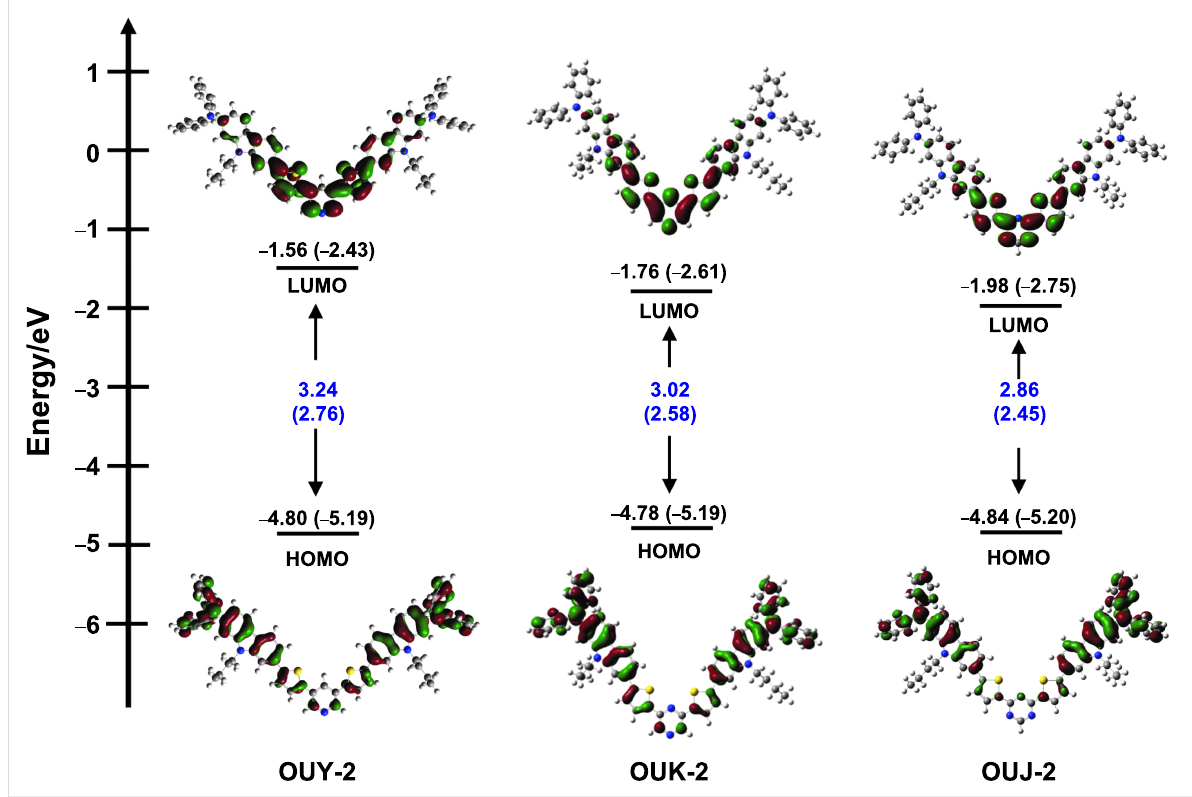
Figure 6: Energy level diagram, HOMO and LUMO of OUY-2 , OUK-2 and OUJ-2 , derived from the DFT calculations at the B3LYP/6-31G(d,p) level of theory. Numbers in parentheses are the experimental values.